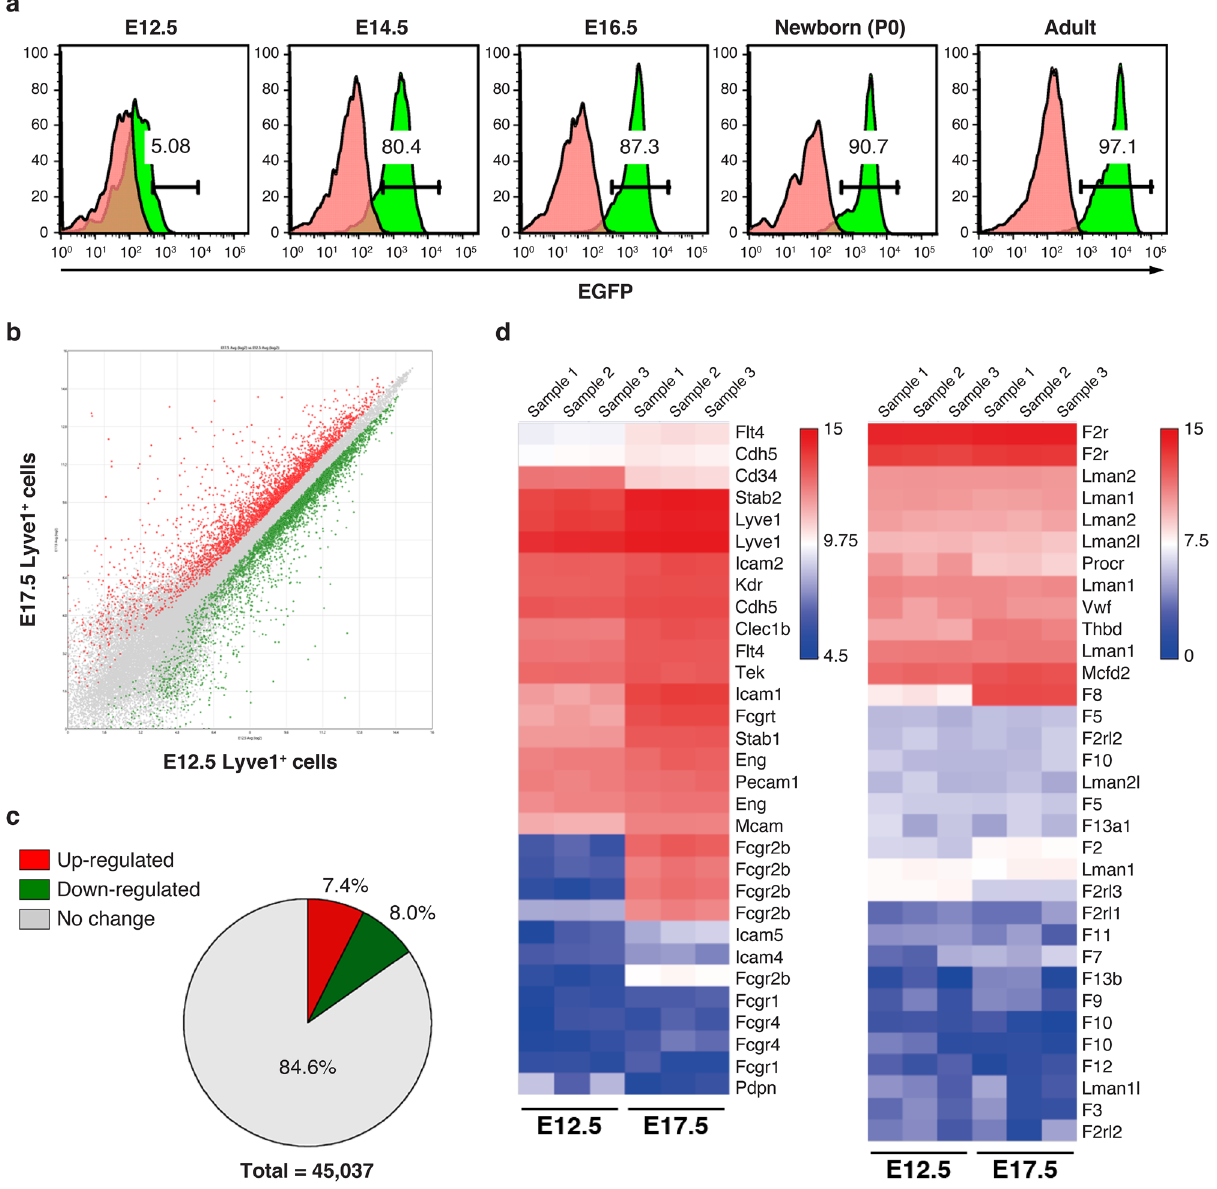
Figure 4. Microarray analysis of Lyve1-positive cells in liver during embryonic development. ( a ) Liver cells were obtained from fetal (E12.5, E14.5, and E16.5), newborn (P0), and adult WT and F8 Δ -KI mice. After the exclusion of dead cells and CD45 + cells, EGFP expression was detected in CD31 high CD146 high Lyve1 + CLEC-2 + population. Pink-filled and green-filled histograms indicate WT and F8 Δ -KI mice, respectively. The numbers in gated areas indicate the percentage of cells (n = 3). ( b ) Lyve1-positive cells were isolated as CD31 high CD146 high Lyve1 + cells from the liver of C57BL/6J fetal mice (E12.5 and E17.5) (n = 3). Scatter plot of differentially expressed genes in E12.5 Lyve1 + cells and E17.5 Lyve1 + cells. Red and green dots indicate upregulated and downregulated genes with a greater than twofold change, respectively. ( c ) Percentage of upregulated and downregulated genes with a greater than twofold change. ( d ) Heatmap of differentially expressed genes related to coagulation factors and endothelial cell markers between E12.5 Lyve1 + cells and E17.5 Lyve1 + cells. Blue and red colors represent low and high expression levels, (iPSCs) improved the hemophilia A phenotype in mice 39 . Deriving sinusoidal endothelial cells from the patient’s gene-corrected iPSCs may also provide an attractive source for cell-based hemophilia A therapy. This study has some limitations. First, we must consider the species differences to extrapolate the implications of this study to human biology. It is possible that the mechanism of FVIII synthesis differs among species. Indeed, several reports suggest the existence of a compensatory mechanism by other organs to maintain the plasma FVIII. In a porcine model of fulminant hepatic failure caused by a total hepatectomy, plasma FVIII levels increased in the absence of the liver 40 . In addition, previous observations in dogs and humans suggest that the liver may